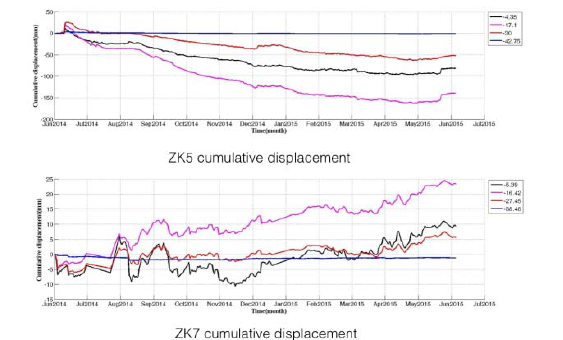
Figure 5. Time series displacements of inclinometers in diverse depths of